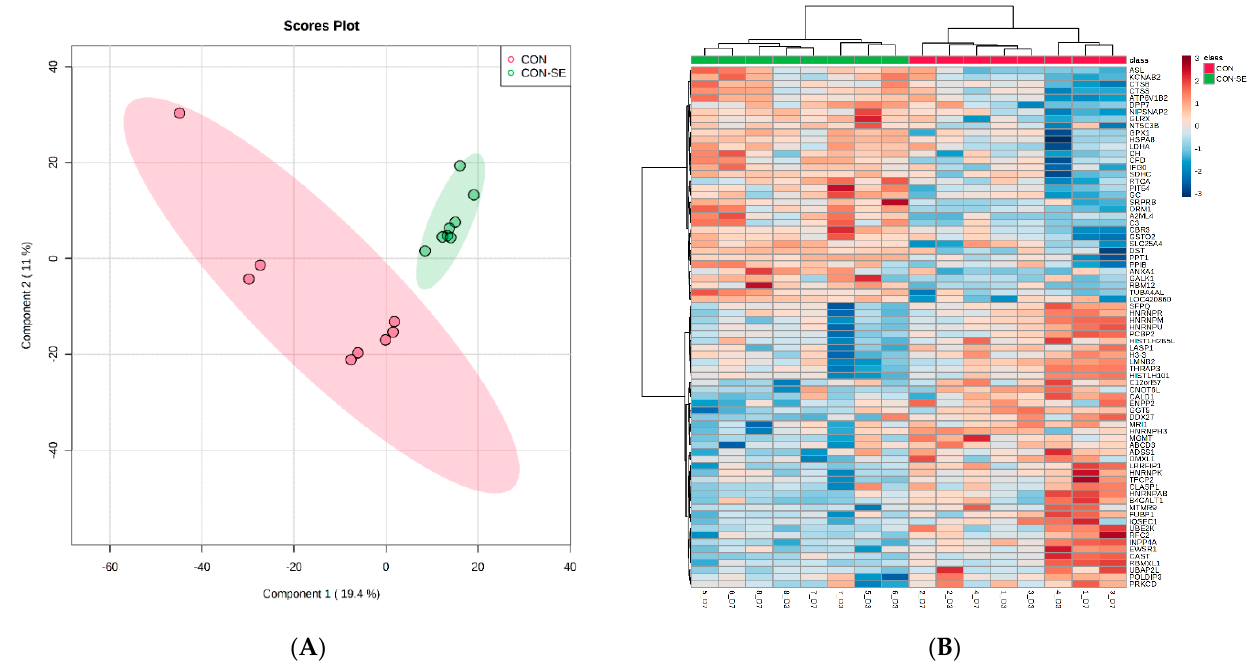
Figure 1. PLSDA ( A ) and heat map and dendrogram of hierarchical cluster analysis ( B ) of proteins isolated from spleen samples collected from CON and CON − SE group broiler-chickens (n = 4) on day 3 and day 7 of growth. PLSDA score plot shows distinct clusters of samples by CON and CON − SE, whereas heatmaps illustrated 75 most differentiating proteins that are greater (red) and lesser (blue) in abundance relative to CON (color-coded red) and CON − SE (color-coded green) at D3 and D7.